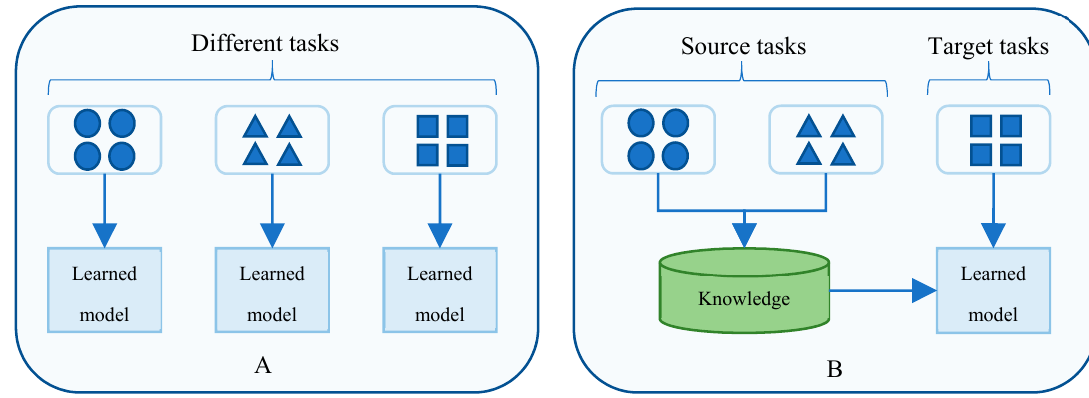
Figure 3. The comparison between ( A ) traditional machine learning and ( B ) transfer learning.